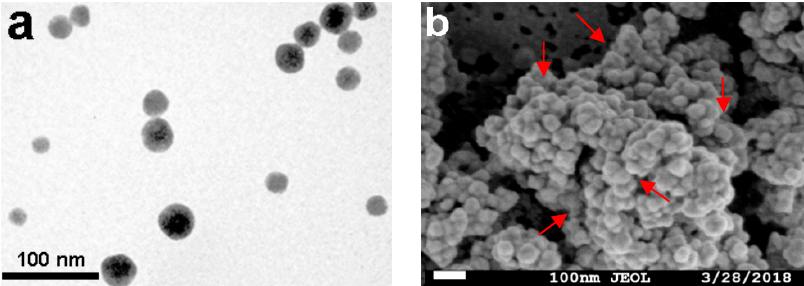
Figure 4. ( a ) TEM images of the Fe 3 O 4 @SiO 2 -NH 2 and ( b ) FE-SEM images of the magnetic combi- CLEAs.